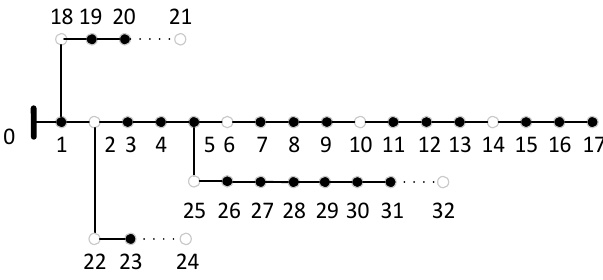
Figure 9. IEEE-33 standard node distribution network.